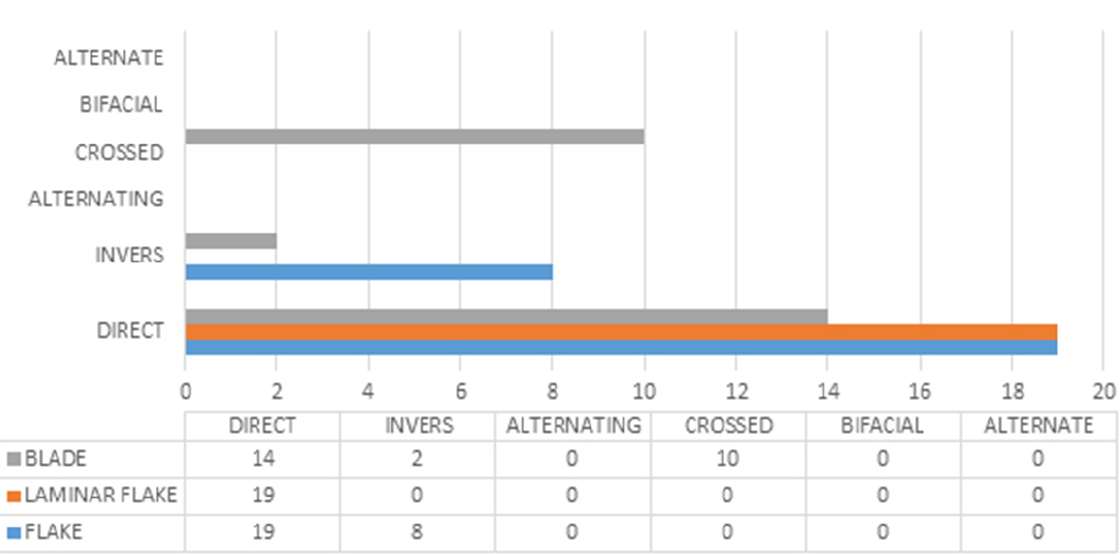
Figure 8. Distribution according to the different types of direction in the